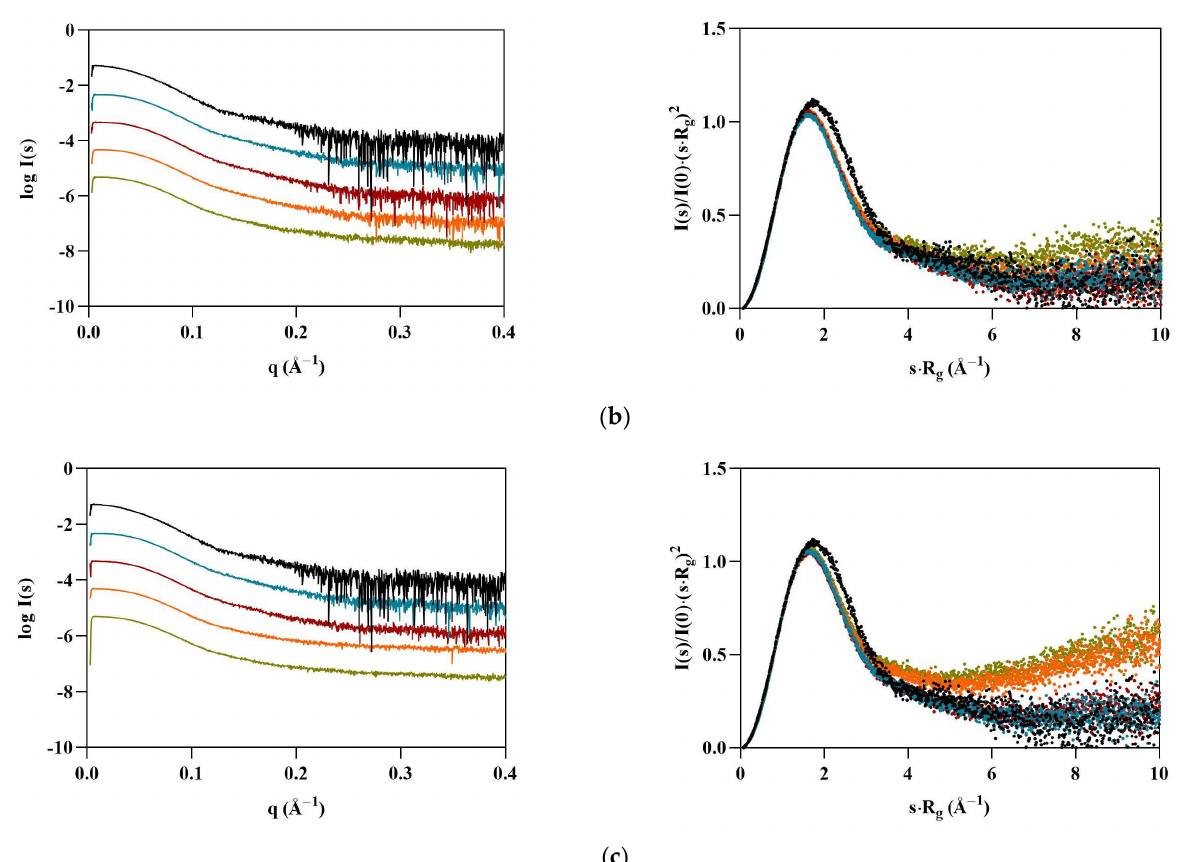
Figure 3. Scaled experimental scattering curves (left) and dimensionless Kratky plots (right) for BSA in the presence of ( a ) [N 1112(OH) ][H 2 PO 4 ], ( b ) [N 1112(OH) ][C 4 F 9 SO 3 ], and ( c ) [C 2 C 1 Im][C 4 F 9 SO 3 ].